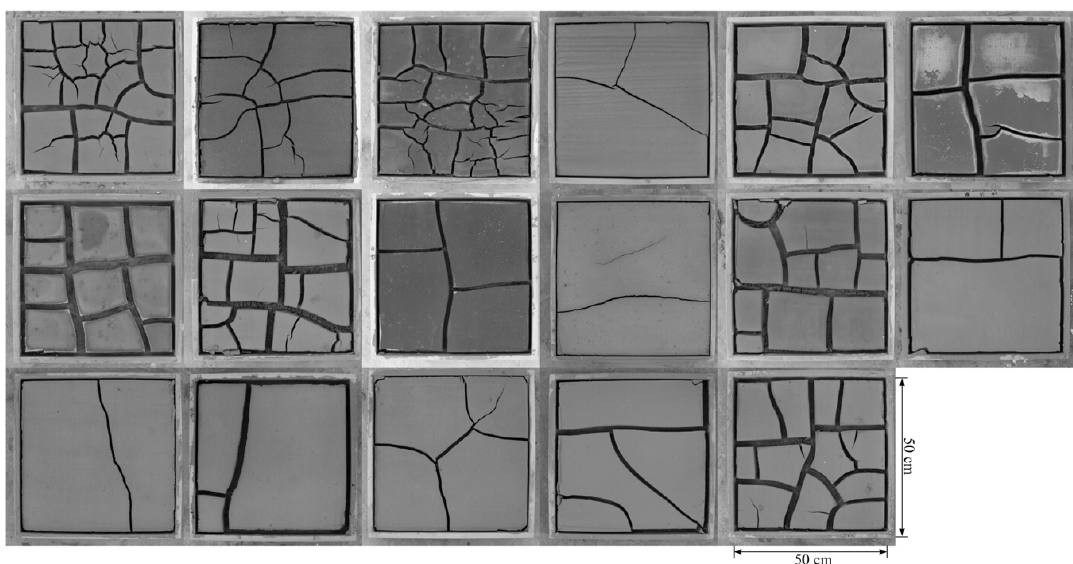
Figure 1. The cracked soil samples after the drying process.